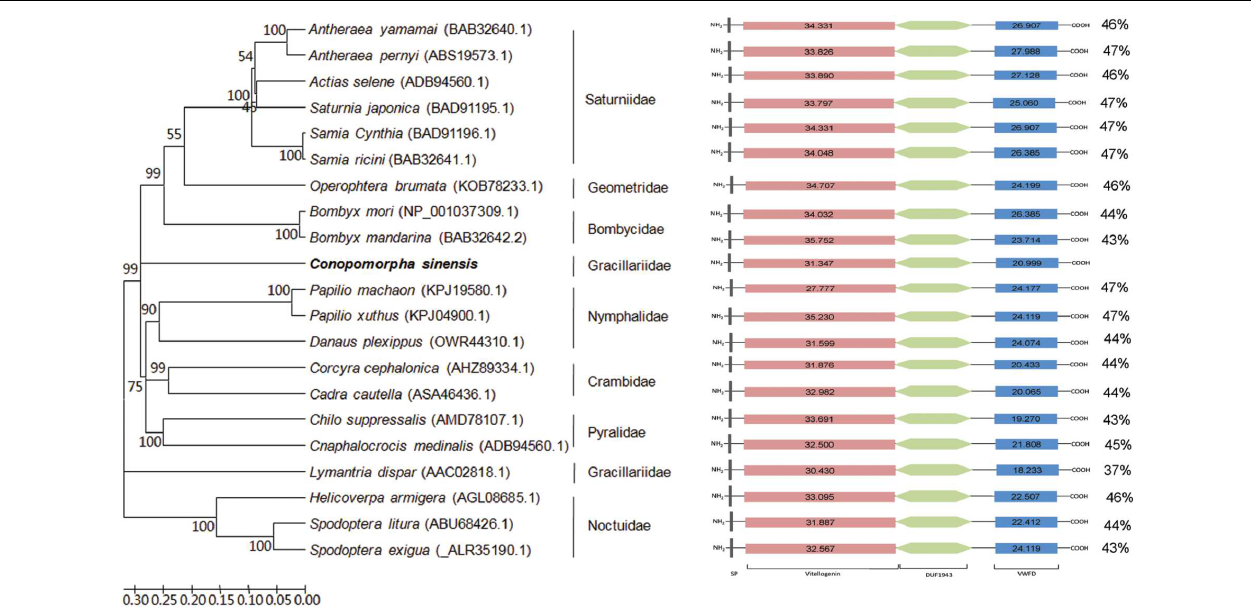
FIGURE 1 | Domain architecture and phylogenetic analysis of lepidopteran vitellogenins (Vgs). A phylogenetic tree was constructed using the sequences of different lepidoptera families. The Conopomorpha sinensis sequence was used as an outlier, and the figure shows a family grouping of the lepidopteran Vgs. The figure shows a comparable domain architecture in lepidopteran Vgs. The percentages on the right indicate the overall identity of each protein compared to CsVg. Scan-Prosite scores for vitellogenin and VWFD domains of Vgs are presented in the schema. DUF1943, Vitellinogen, open beta-sheet; VWFD, von Willebrand factor, type D domain; SP, signal